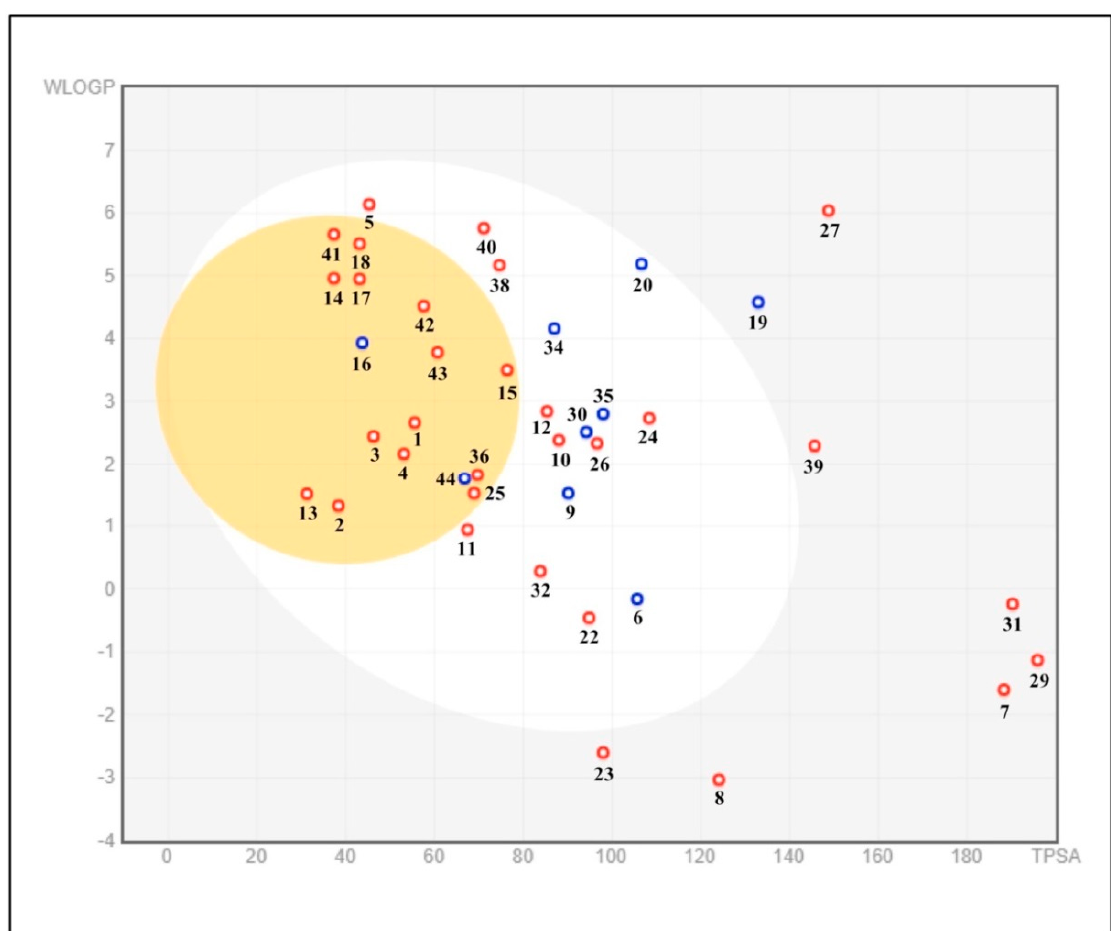
Figure 8. BOILED Egg model of the phytochemical compounds of E. sativa using the Swiss ADME predictor. BOILED Egg allows for the intuitive evaluation of passive gastrointestinal absorption (HIA) and brain penetration (BBB) in function of the position of the molecules in the WLOGP-versus-TPSA referential. The white region indicates the high probability of passive absorption by the gastrointestinal tract, and the yellow region (yolk) indicates the high probability of brain penetration. The yolk and white areas are not mutually exclusive. In addition, the points are colored in blue if predicted as actively effluxed by P-gp (PGP+) and in red if predicted as non-substrate of P-gp (PGP-).